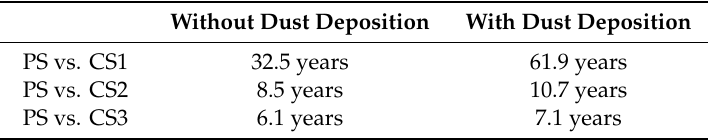
Table 8. Simple pay-back periods as a function of the conventional